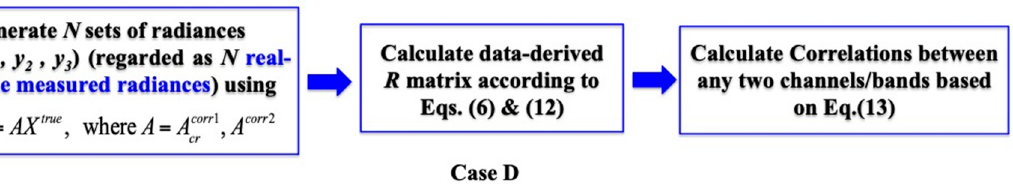
Figure 8. Analysis procedures for Cases D.